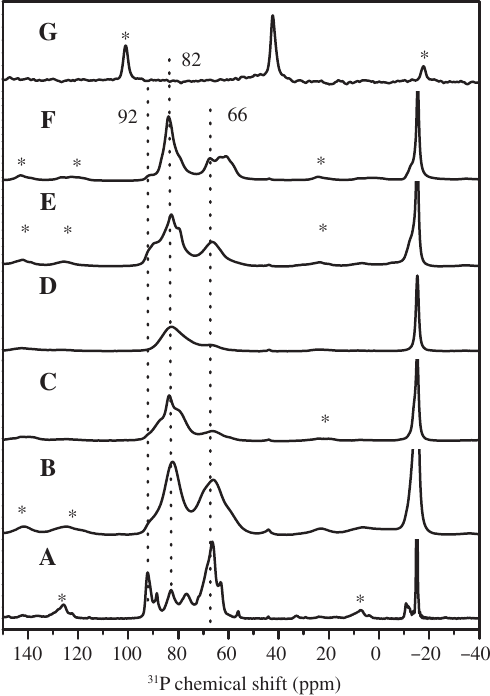
Figure 1: 31 P NMR spectra of TMPO adsorbed on (A) the pristine H PW O and various organic TPA catalysts: (B) [DMBPSH]H 3 12 40 (C) [DMBPSH] HPW O , (D) [DMBPSH] 2 12 40 The asterisks in the spectra denote spinning